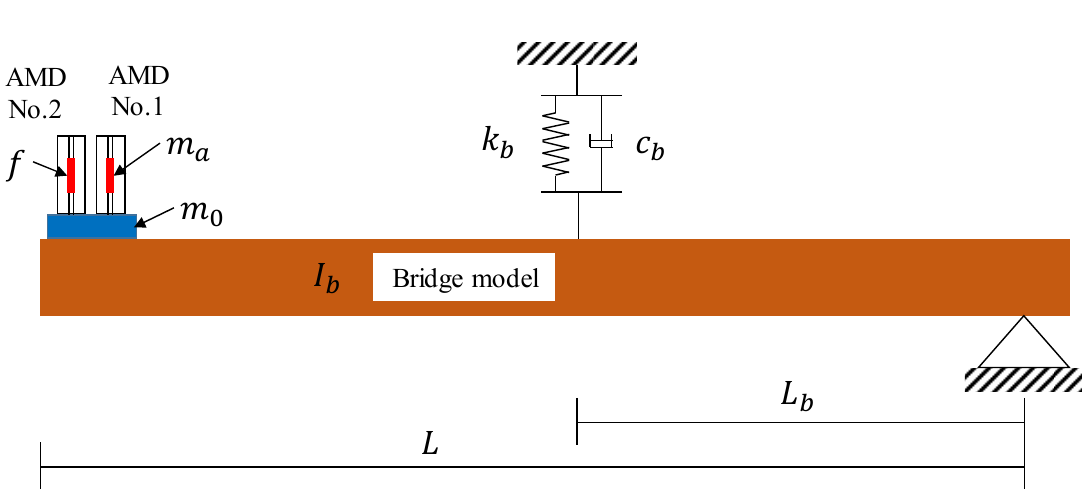
Figure 6. Block diagram of the entire system.